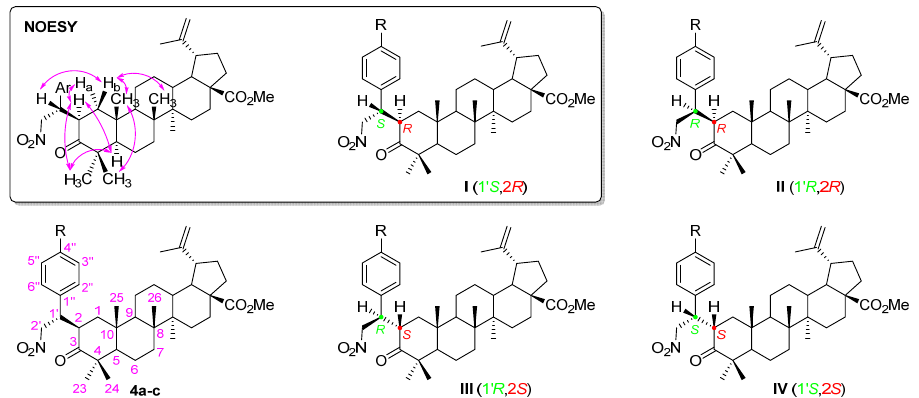
Figure 3. Adopted numbering system, structures of four possible diastereomers I to IV and main NOE effects